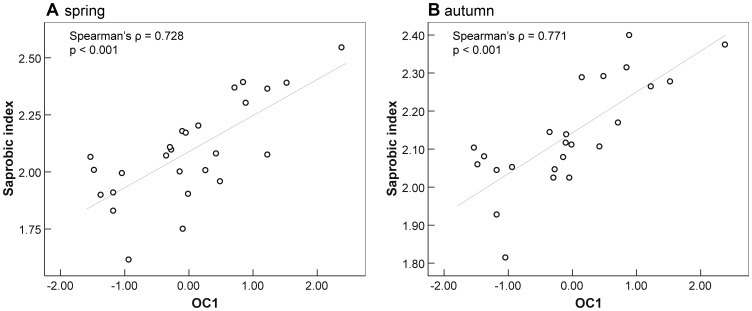
Saprobic index correlating with the first component of the PCA with organic contaminants (OC1).Displayed are results for sampling campaign in spring (A) and autumn (B). Please note different scaling of y-axes in A and B.